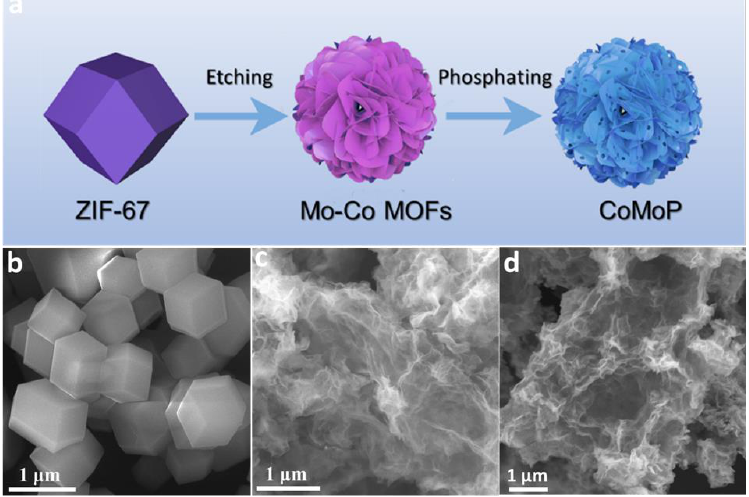
Figure 1. ( a ) Schematic illustration of the CoMoP synthesis process. ( b – d ) SEM image of ( b ) ZIF-67 ( c ) Mo – Co MOFs and ( d ) CoMoP.